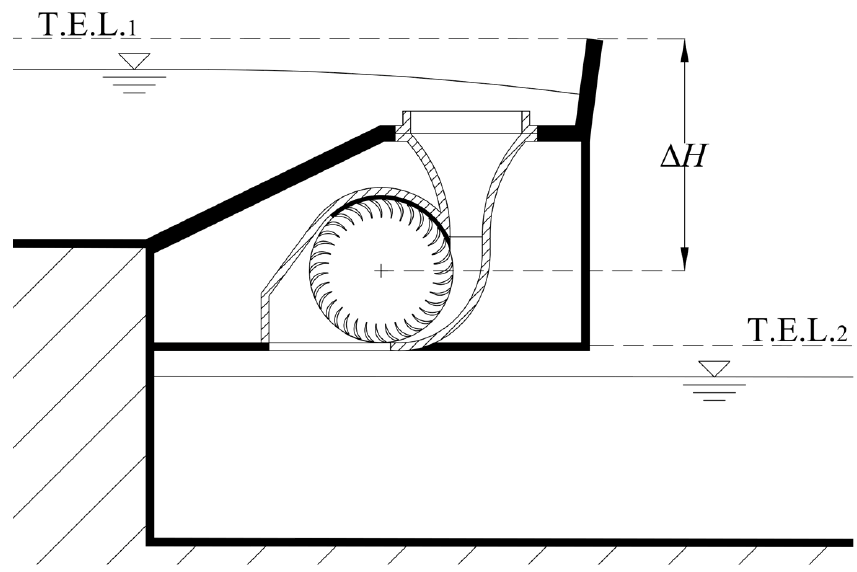
Figure 1. Typical installation of a traditional cross-flow turbine where T.E.L. both time is the total energy level in the upstream and downstream channels, and Δ H is the usable hydraulic jump, lower than the entire available one.